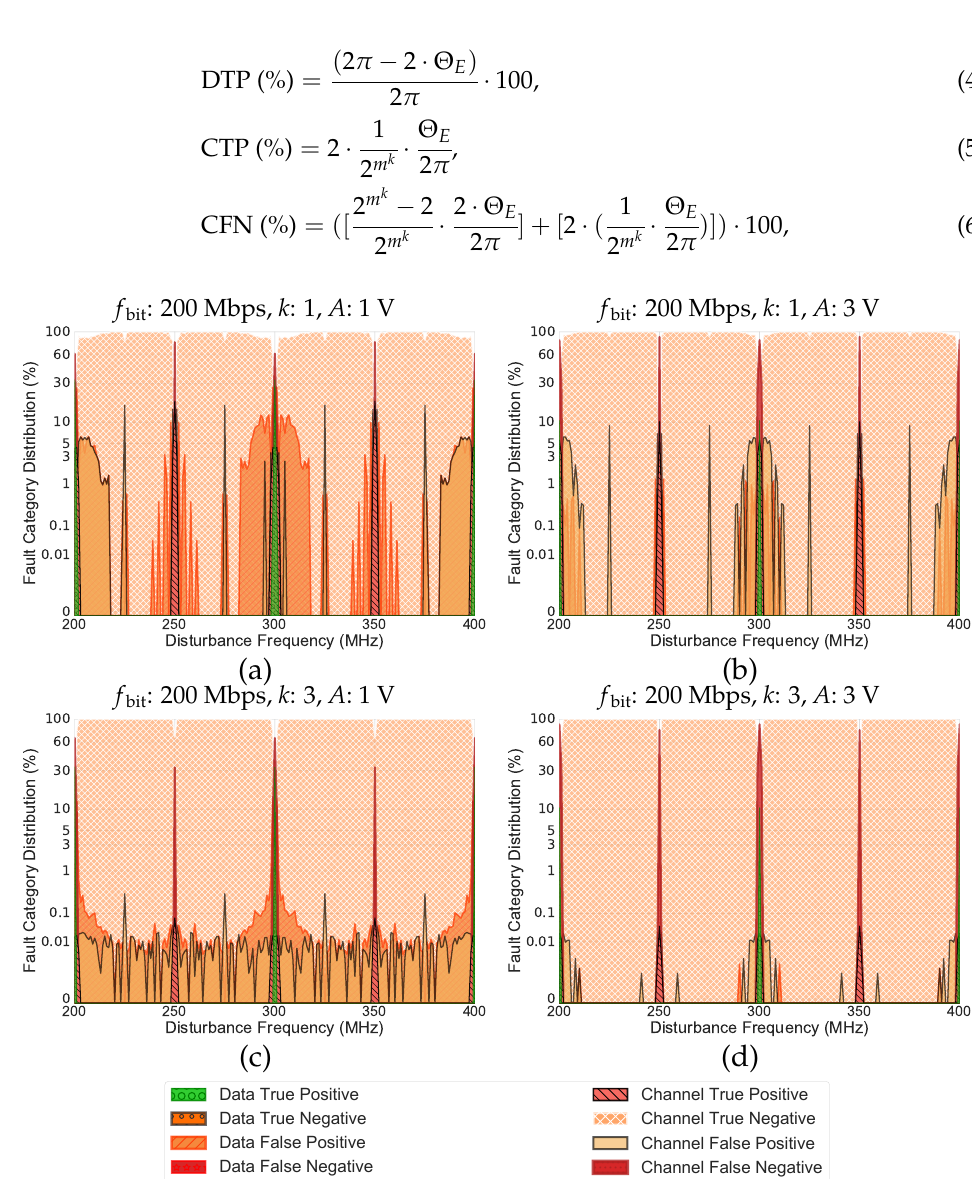
Figure 3. Reed–Solomon Codes Effectiveness under single-frequency electromagnetic disturbances for the symbol size of